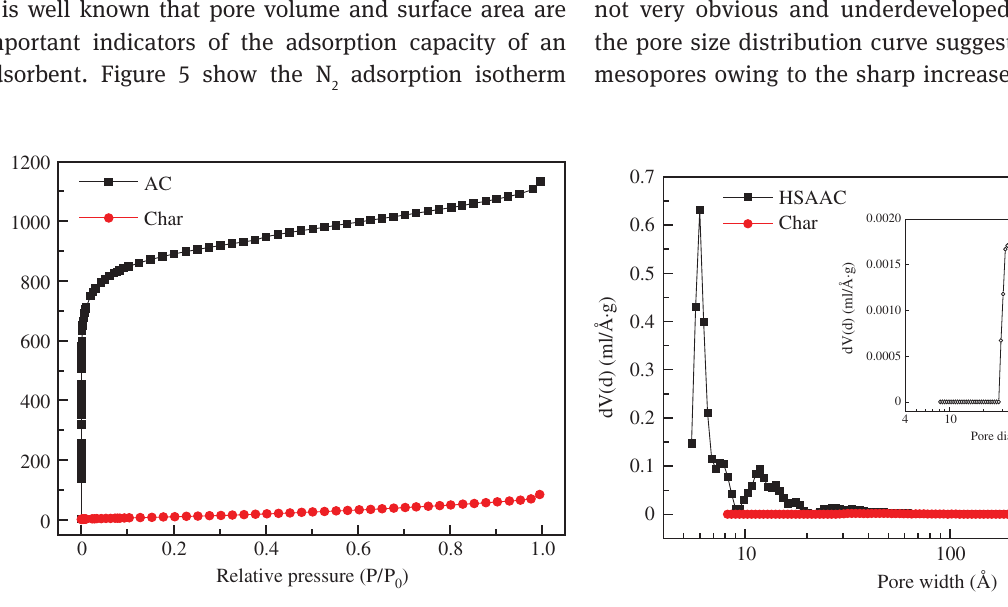
Figure 5: Nitrogen adsorption isotherms of char and high surface area activated carbon (HSAAC).